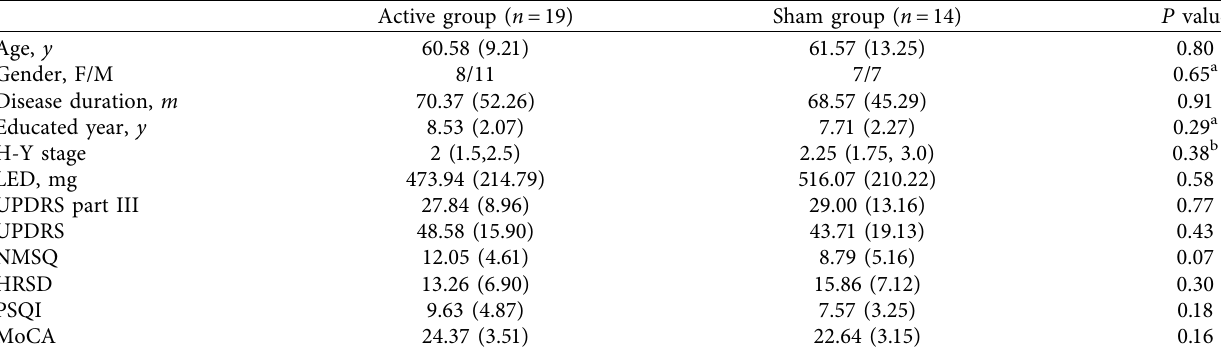
Table 1: Demographic and baseline characteristics of participants.